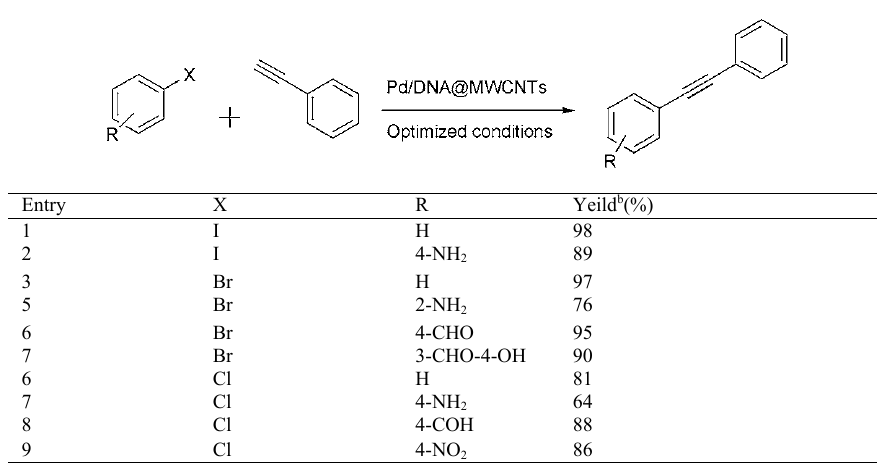
Table 3. Sonogashira cross-coupling of various aryl halides in the presence of the catalyst. a